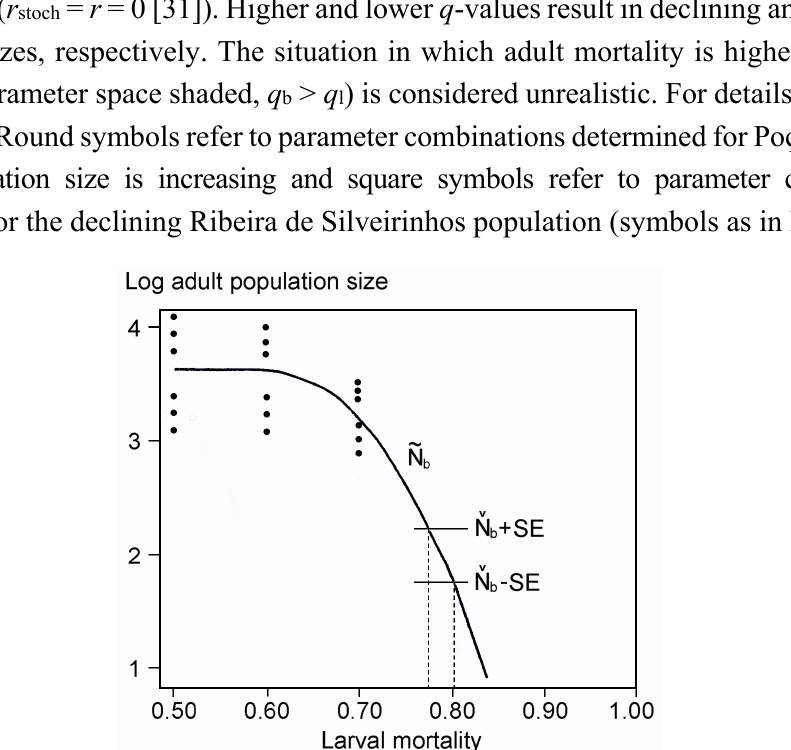
Figure 4. Adult population size of Chioglossa lusitanica at the Ribeira de Silveirinhos modeled with Vortex (log Ñ b median value, vertical axis) as a function of larval mortality ( q l , horizontal axis) modeled with Vortex under a carrying capacity of K = 33,000. The year is 2010, i.e. , at 30 years after the widespread planting of gum trees. The dots drawn in for low q l values represent the modeled variation in carrying capacity of, from top to bottom, 100,000, 70,000, 50,000, 20,000, 10,000 and 7000. Note that the size of the breeding population is about 1/5th–1/6th of the total population; for details see Figure A3 in Appendix 3. The horizontal lines represent the adult population size as estimated in 2010 (log Ň b ± SE) and the interrupted vertical lines indicate the values of larval mortality at which modeled and observed data coincide, at around q l = 0.78 (0.77 < q l <